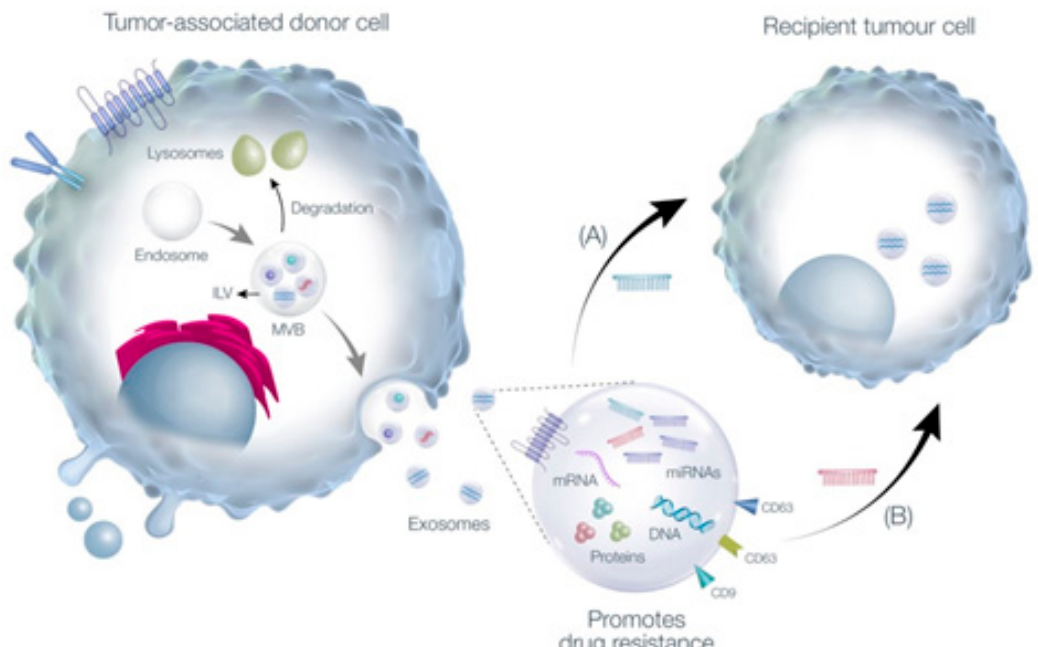
Figure 1. Tumor-associated cells (cancer stem cells, tumor specific cells, tumor-associated fibroblasts, or cancer- associated macrophages) have been described in the literature as being capable of promoting chemoresistance in surrounding and distant recipient cells [18]. Furthermore, resistance to chemotherapy can be promoted through the transfer of miRNAs, which are specifically sorted into intraluminal vesicles (ILV), present in multivesicular bodies (MVB) within the donor cell. Subsequently, exosome release takes place when these MVBs fuse with the plasma membrane, instead of continuing their path towards the lysosome for degradation. Most importantly, the downregulation or upregulation of distinct exosomal-derived miRNAs, as indicated in blue (A) and red (B), has also been described as vital in establishing a fine balance, which may be capable of favoring drug resistance by promoting the development of several drug resistance mechanisms, such as drug efflux, DNA damage repair, altered drug metabolism, energy programming deregulation, and epigenetic changes in recipient cells present in the tumor microenvironment [19].